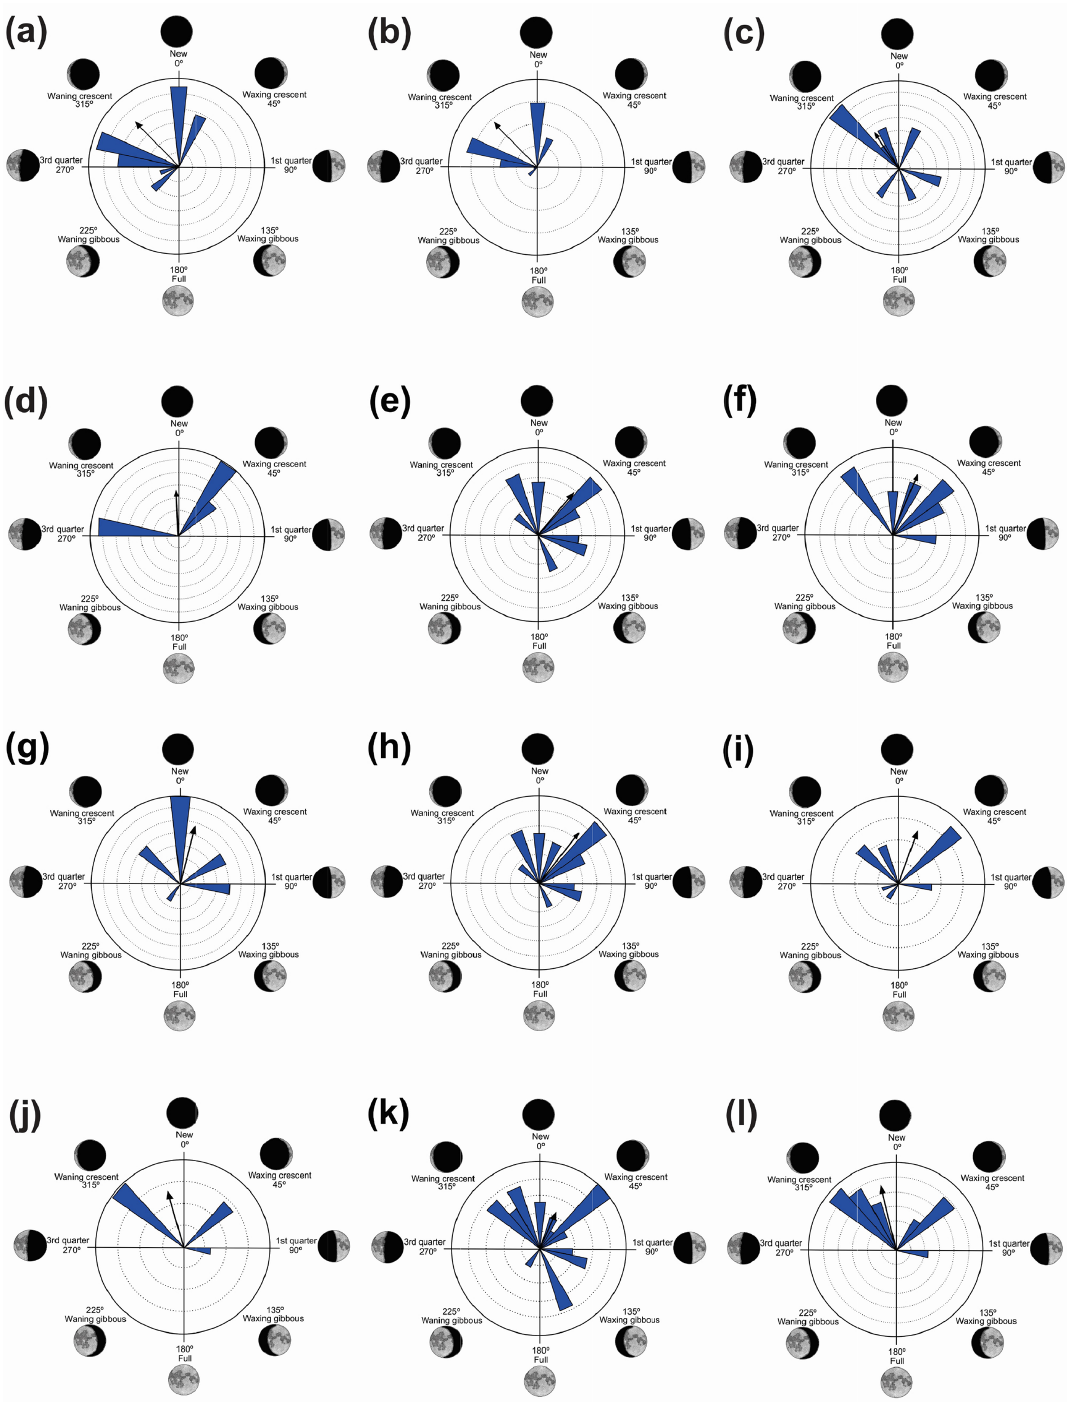
Figure 3. Species with unidirectional behavior in quadrant I of the polar axis (315–45 ◦ ) clockwise, under the influence of the synodic cycle between the waning crescent and waxing crescent (lower albedo): (a) Aplastodiscus albofrenatus , (b) A . arildae , (c) Dendropsophus minutus , (d) Ischnocnema parva , (e) Leptodactylus furnarius , (f) L . fuscus , (g) Odontophrynus americanus , (h) Physalaemus cuvieri , (i) S . duartei , (j) Scinax aff. hayii , (k) S . crospedospilus , and (l) Vitreorana uranoscopa .